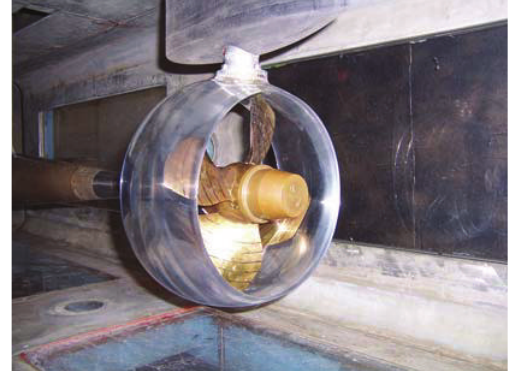
Figure 12: Measurement setup at cavitation tunnel.